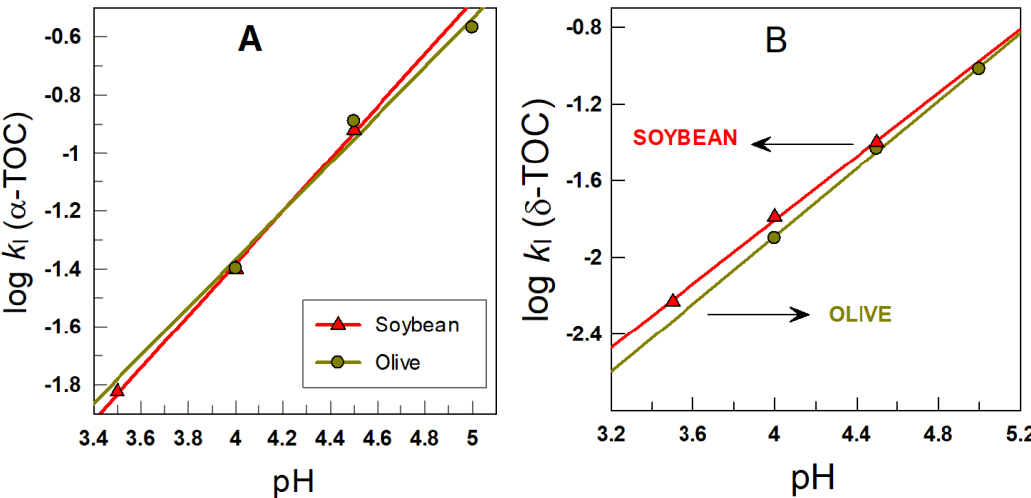
Figure 4. Linear variations of logarithm of the interfacial rate constant k I with pH for the reaction between 16 − ArN 2+ and α− TOC ( A ) and δ− TOC ( B ) in 1:9 ( o : w ) emulsions prepared with olive ( ⚫ ) and soybean ( ) oils).